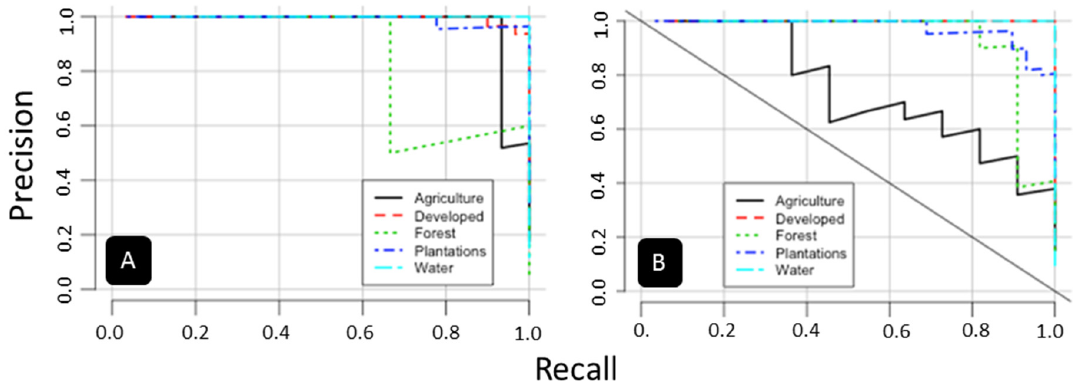
Figure 9. Precision and recall values for ( A ) West Kalimantan and ( B ) Tanintharyi.